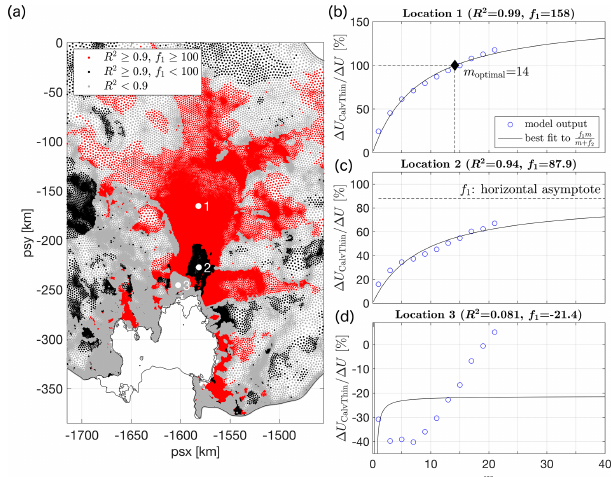
Figure C1. (a) Goodness of fit between f 1 m and model simula- m + f 2 /(U 16 − U 96 ), m i ∈ { 1 , 3 , ··· , 21 } . Red areas cor- tions (cid:49)U m i CalvThin respond to R 2 ≥ 0 . 9 and fitting parameter f 1 ≥ 100. An example of the fit at location 1 and resulting m optimal (Eq. 7) is shown in panel (b) . Black areas in panel (a) correspond to R 2 ≥ 0 . 9 and fitting parameter f 1 < 100. The horizontal asymptote with limit < 100 indicates that a positive, finite solution m optimal does not exist, and Weertman sliding cannot reproduce 100% of the ob- served changes in surface velocity. An example of the fit and asymp- tote at location 2 is shown in panel (c) . Grey areas in panel (a) correspond to R 2 < 0 . 9, indicating a poor fit between f 1 m and m + f 2 (cid:49)U m i /(U 16 − U 96 ), m i ∈ { 1 , 3 , ··· , 21 } . An example at loca- CalvThin tion 3 is shown in panel (d)